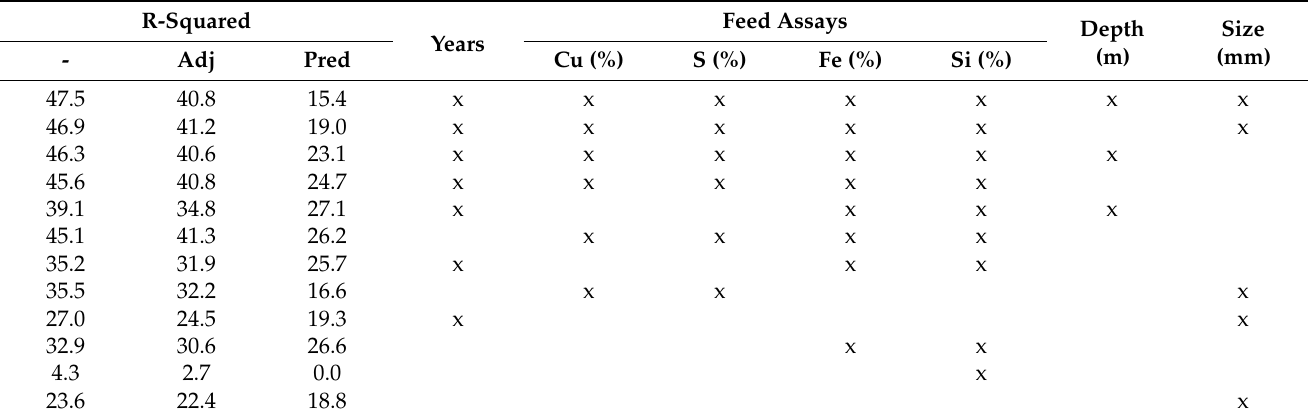
Table 8. Analysis of the best linear regression subsets.